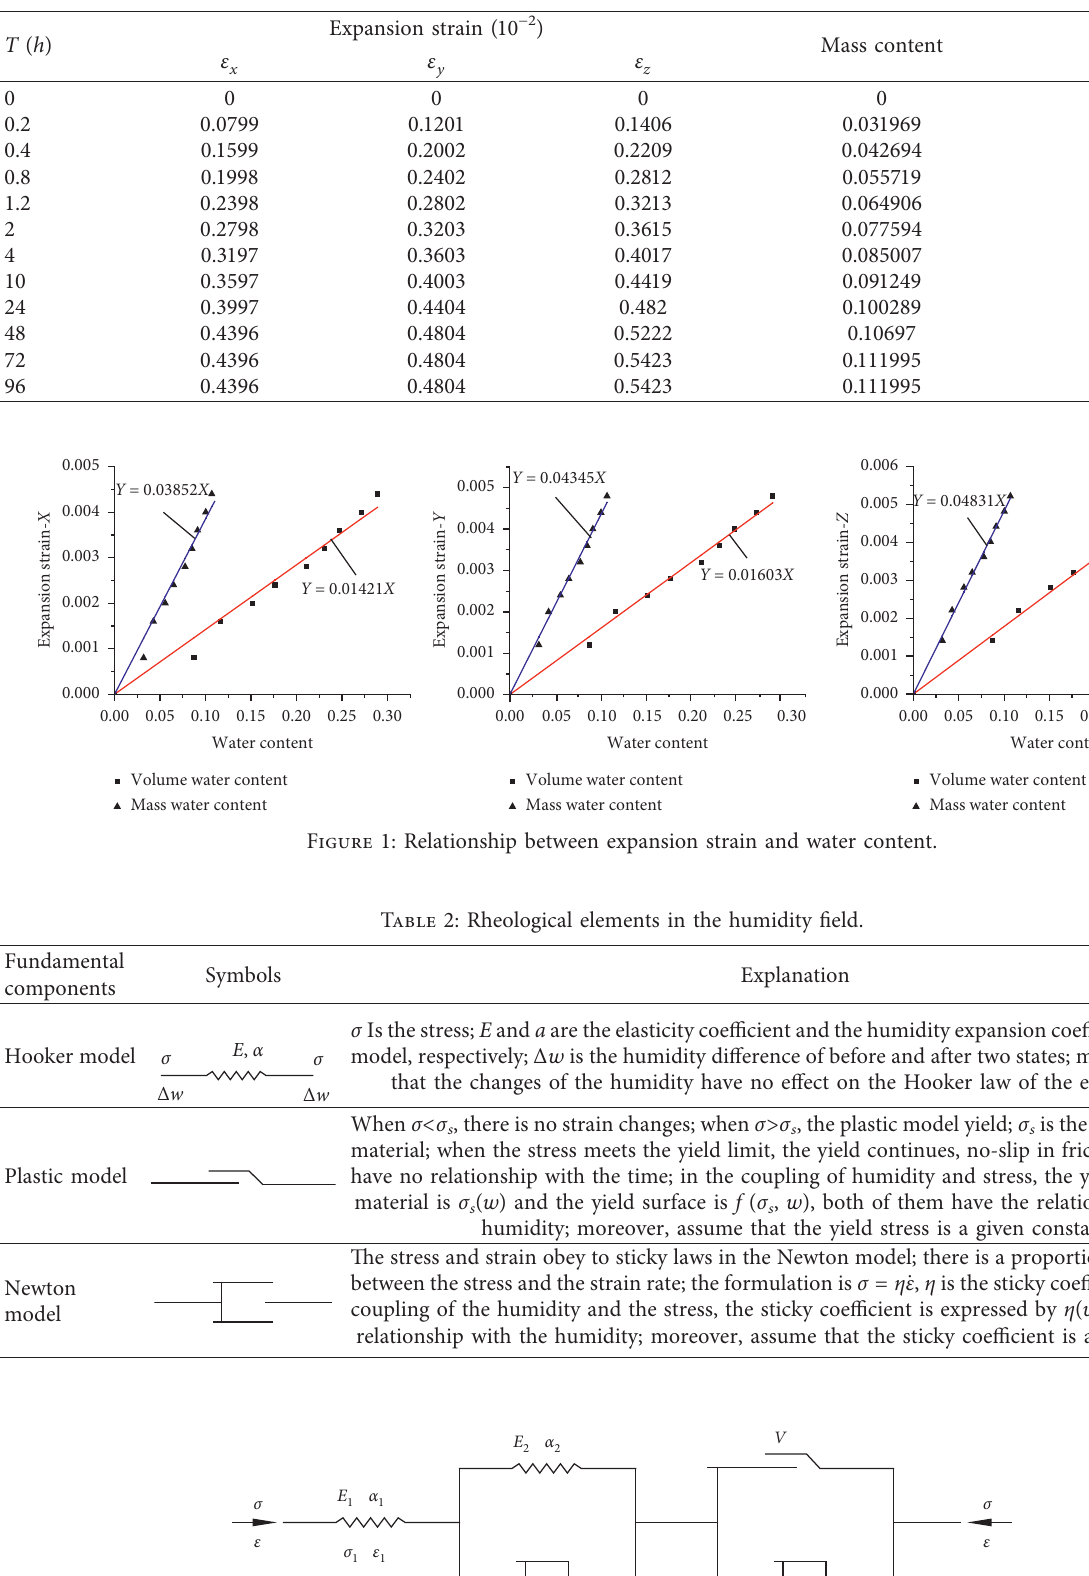
Table 1: Experiment results.